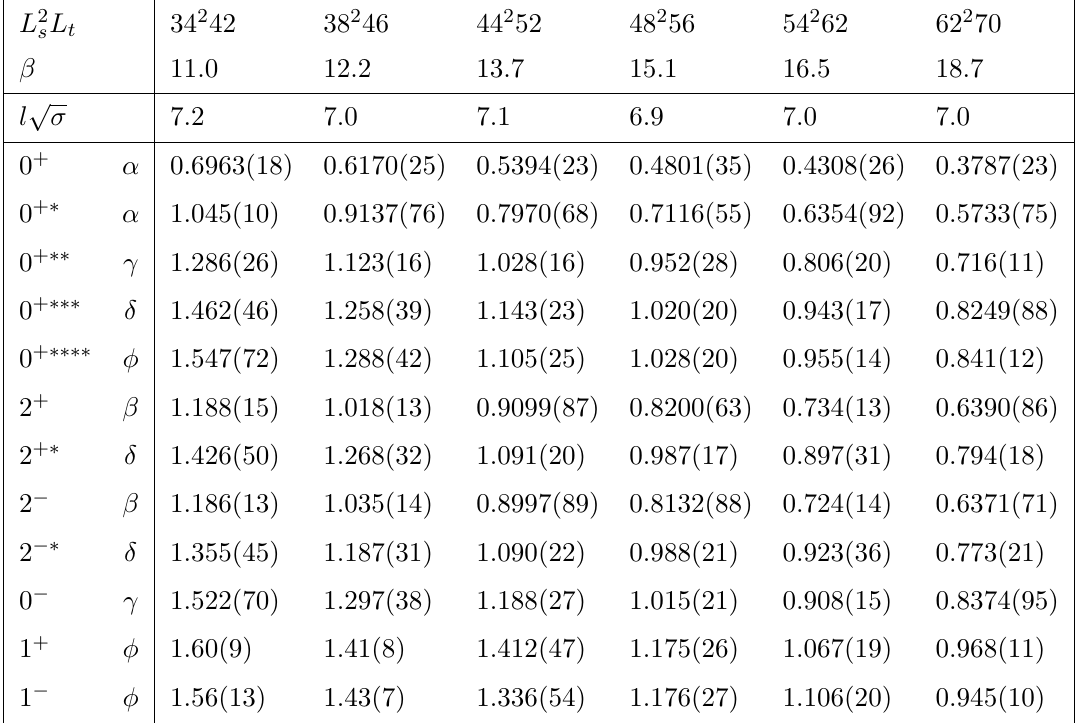
Table 21 . SO(4) glueball masses am G . Grades, e.g. (cid:11) , explained in section 3.6.6.